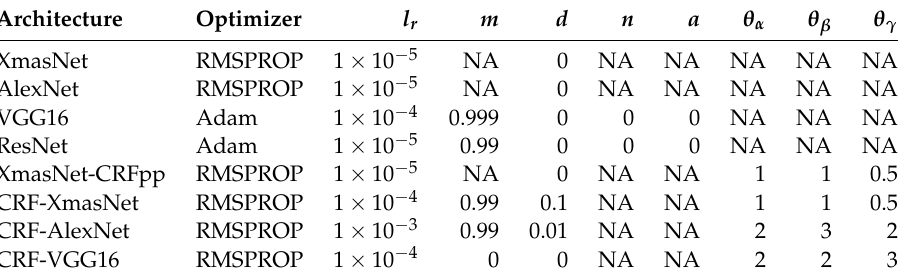
Table 5. Best performing configuration of each architecture. NA denotes Not Applicable.